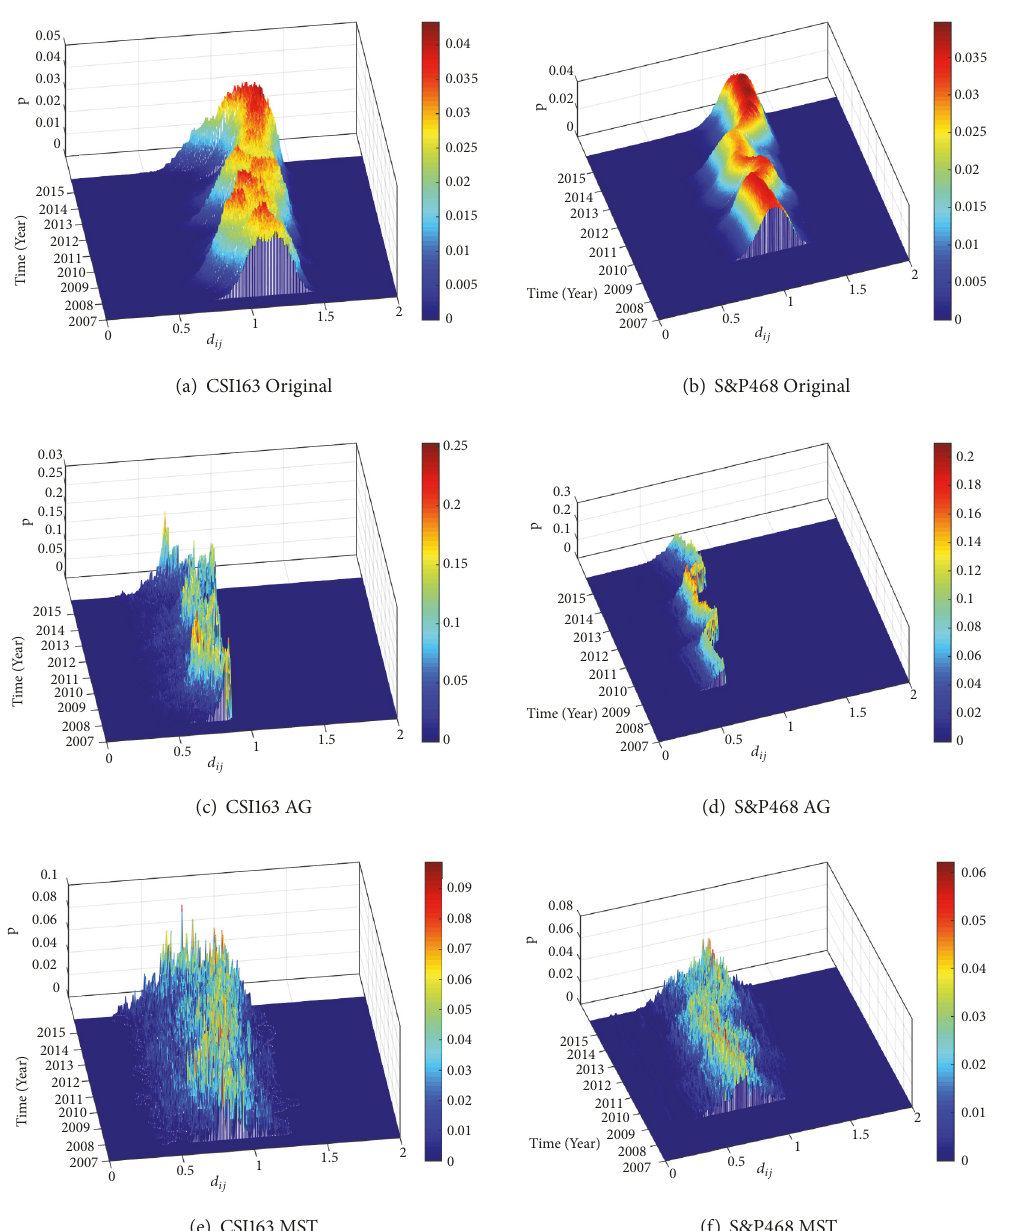
Figure 22: Probability distributions of all distances 𝑑 𝑖𝑗 of 𝑁 𝑡 , 𝐴𝐺 𝑡 , and 𝑀𝑆𝑇 𝑡 of CSI163 and S&P468 over the years in our study period between 04/01/2007 and 06/11/2015. The total number of edges is 𝑁(𝑁 − 1)/2 for 𝑁 𝑡 , and 𝑁 − 1 for 𝐴𝐺 𝑡 and 𝑀𝑆𝑇 𝑡 , respectively. Since the sliding window size 𝐿 𝐶𝑆𝐼163 = 170 and 𝐿 𝑆 & 𝑃468 = 500 , so the data only starts after a period of 𝐿 .